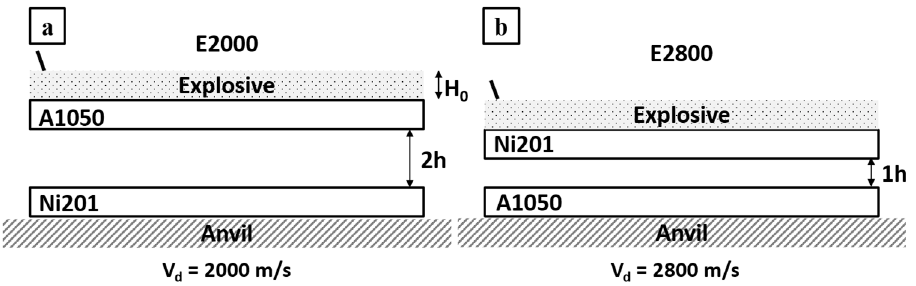
Figure 1. Scheme of the experimental set-up of ( a ) A1050/Ni201 manufactured with V d = 2000 m/s and ( b ) Ni201/A1050 manufactured with V d = 2800 m/s.